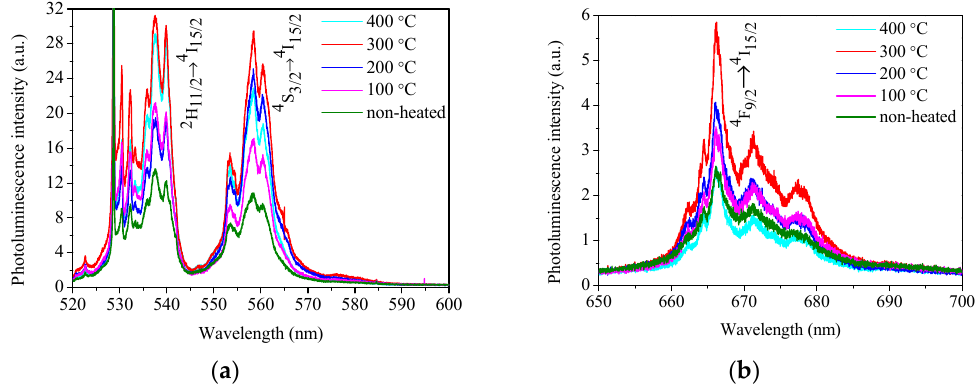
Figure 12. Photoluminescence spectra of AlN:Er films deposited at various substrate temperatures ( a ) the main peak locates around 540 nm and 560 nm corresponds to the 2 H 11/2 → 4 I 15/2 and the 4 S 3/2 → 4 I 15/2 electronic transitions of Er 3+ ions, respectively and ( b ) the weak emission peak locate around 670 nm corresponds to the 4 F 9/2 → 4 I 15/2 transition.